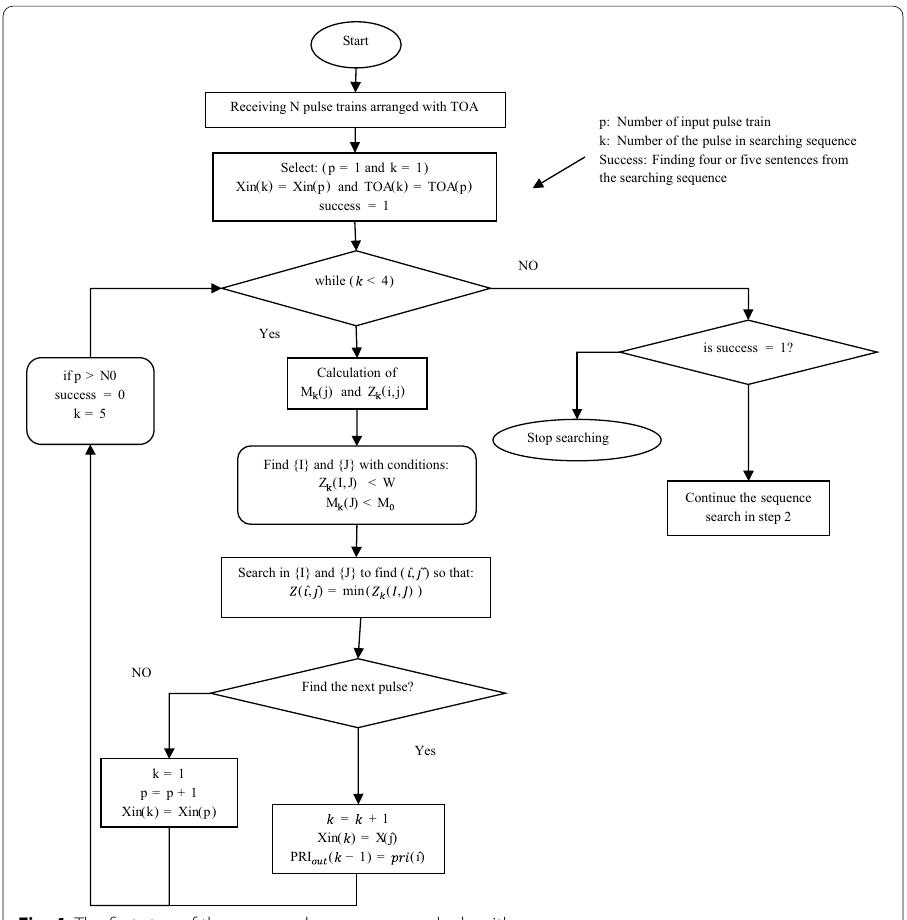
Fig. 4 The first step of the proposed sequence search